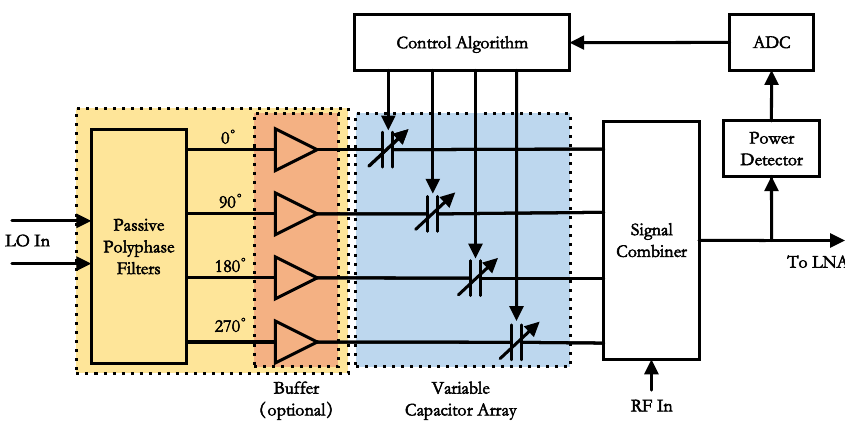
Figure 2. The architecture of the SJC